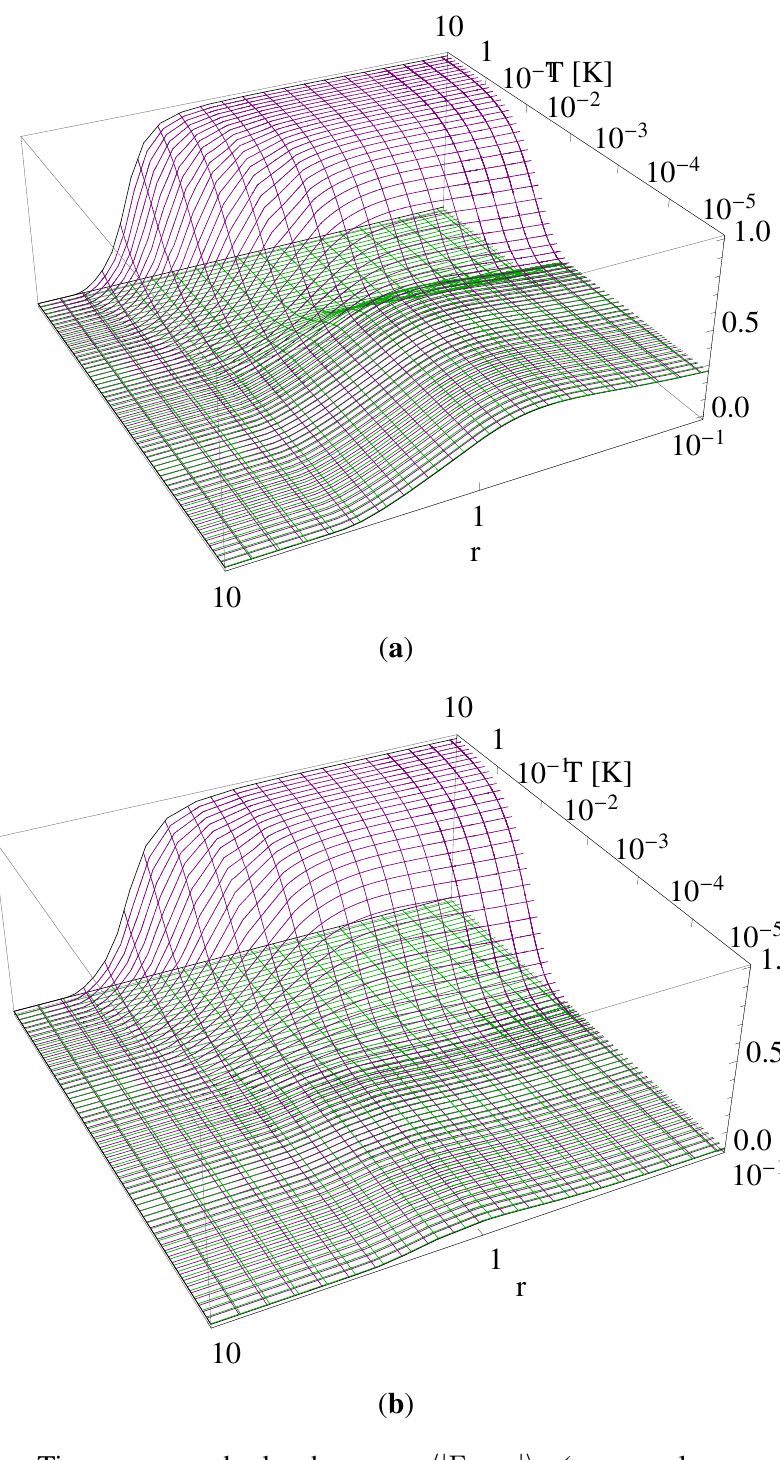
|(cid:105) (green; lower surfaces) and Figure 1. Time averaged decoherence (cid:104)| Γ X,X (cid:48) (cid:105) (magenta; upper surfaces) factors as functions of the temperature distinguishability (cid:104) B mac X,X (cid:48) T and squeezing r (both on the logarithmic scale) of the environment. The set of random frequencies ω was generated once per plot. The traced over and observed macrofractions, k (1 − f ) E and mac , are assumed to be of the same size. Both plots simultaneously approaching zero indicates formation of the spectrum broadcast structure for a given ( r, T ) . ( a ) 10 oscillators; ( b ) 30